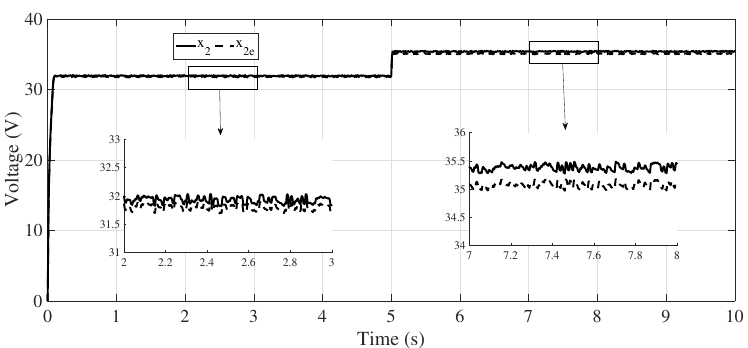
Figure 8. Output voltage.